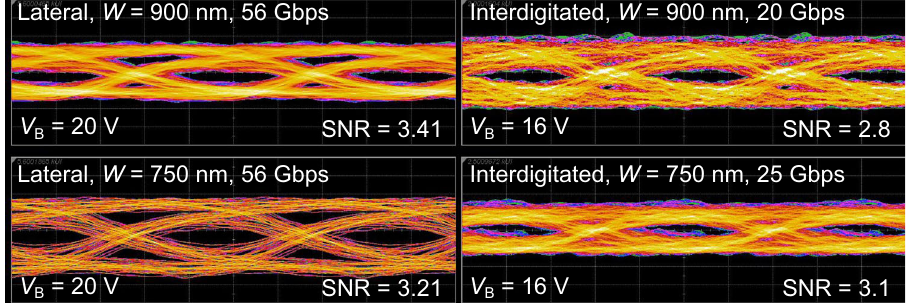
Fig. 5 Measured eye diagrams for the different device types. Lateral devices show open eyes at data rates of up to 56 Gbps at V B = 20 V, where the maximum GBP is observed. The results for interdigitated devices are obtained at the highest data rate where open eyes could be measured for each device. The signal-to-noise ratio (SNR) is obtained from the sampling